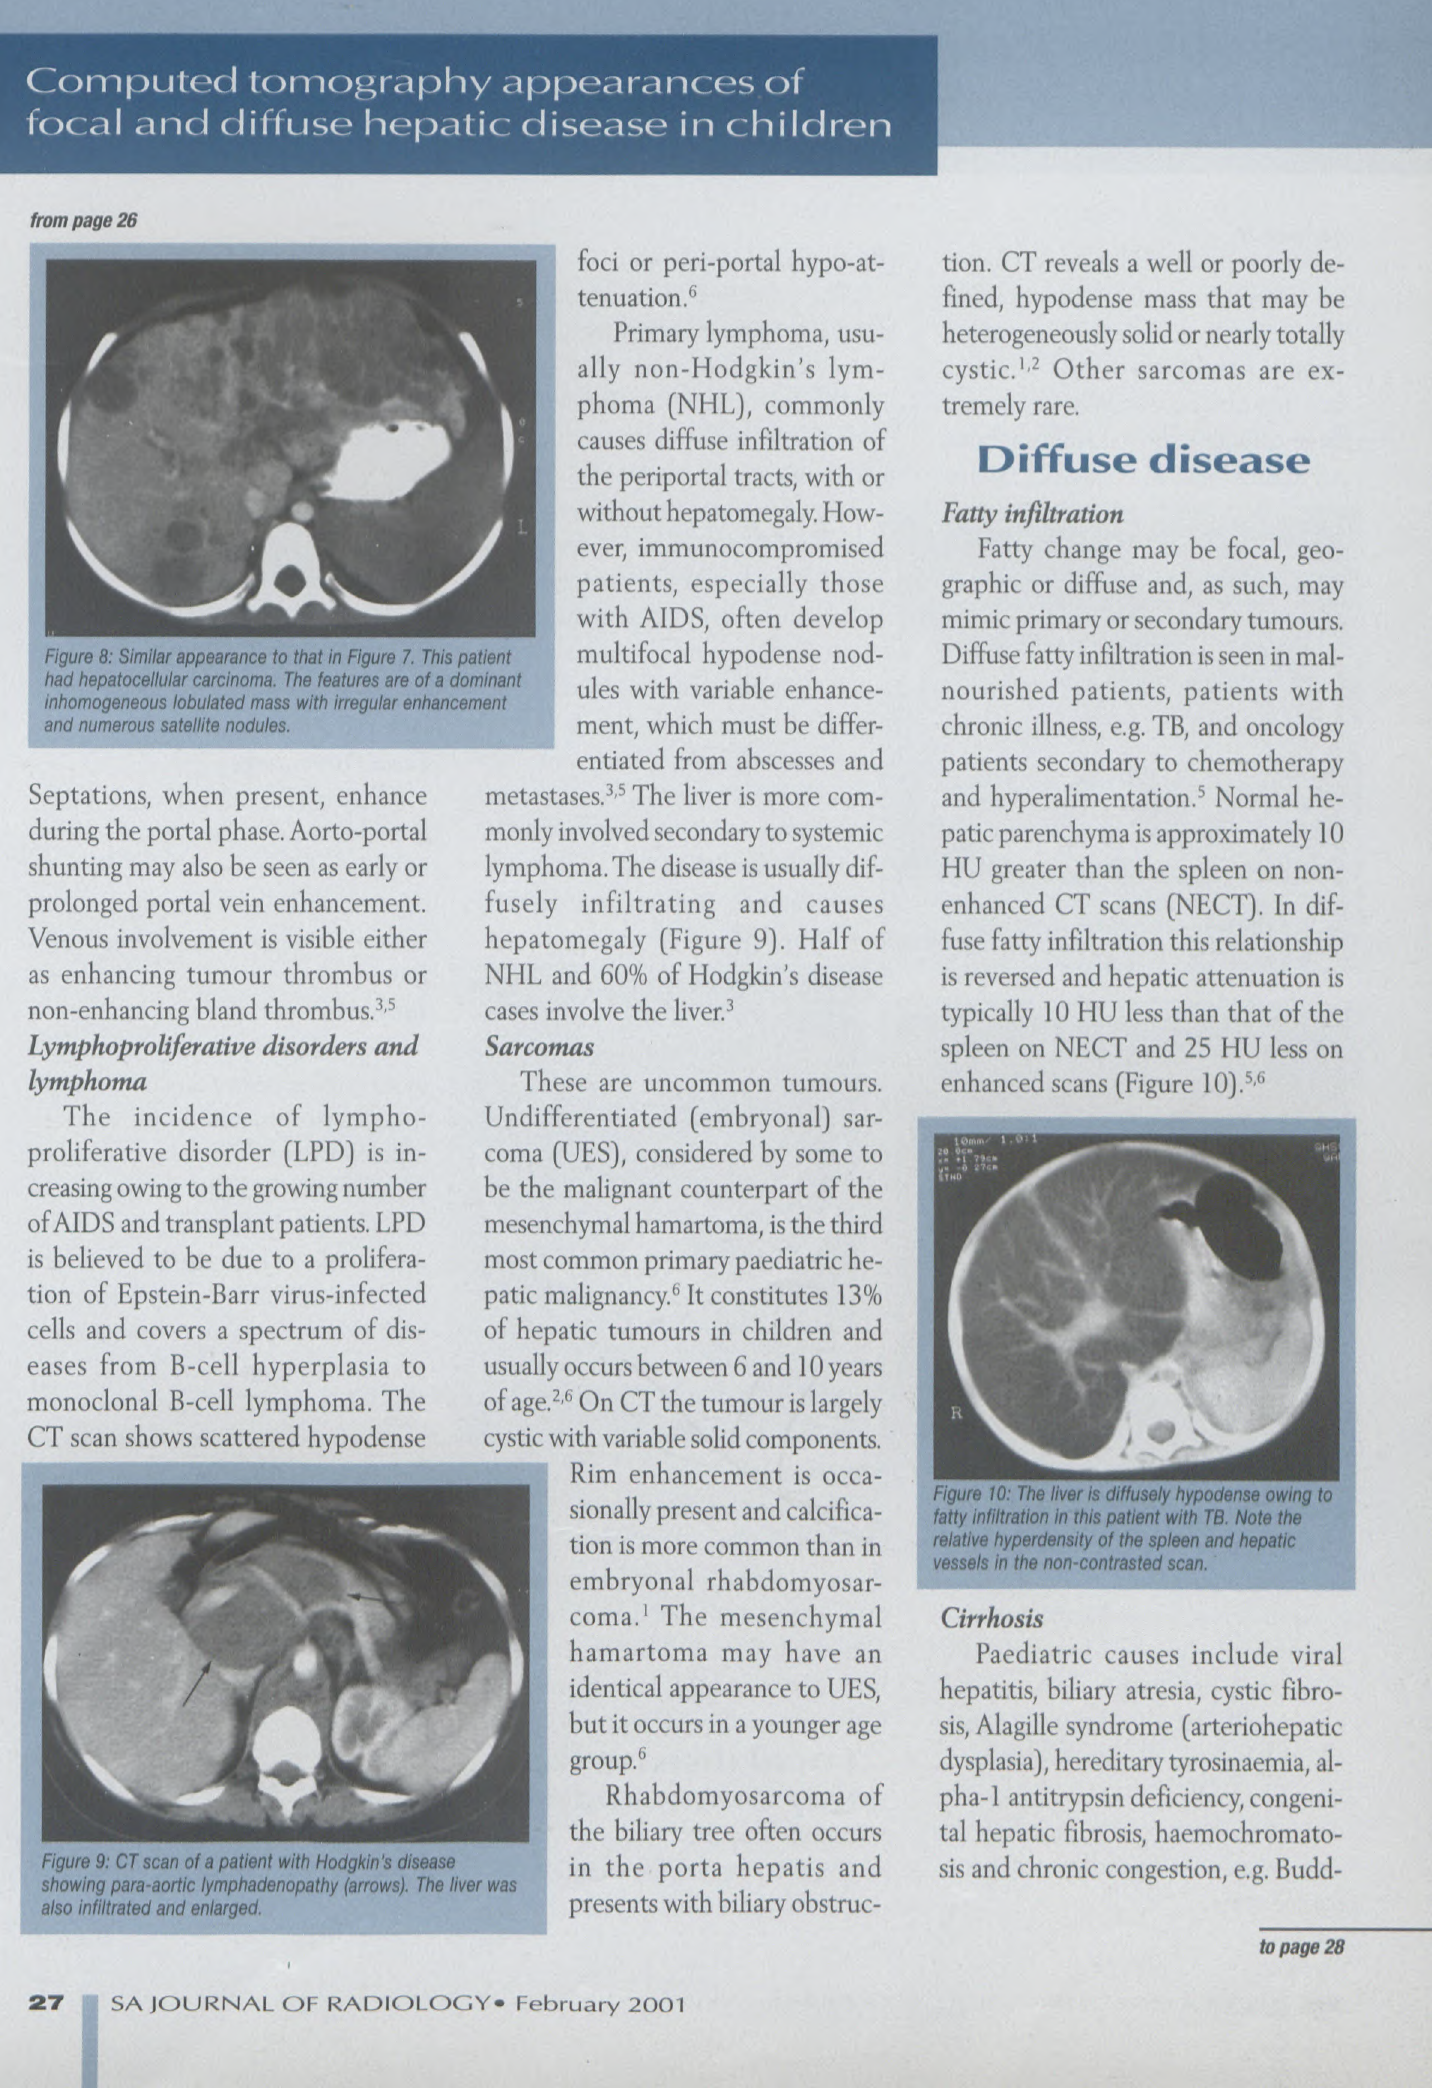
Figure 10: The liver is diffusely hypodense owing to fatty infiltration in rhis patient with TB. Note the relative hyperdensity of the spleen and hepatic vessels in the non-contrasted